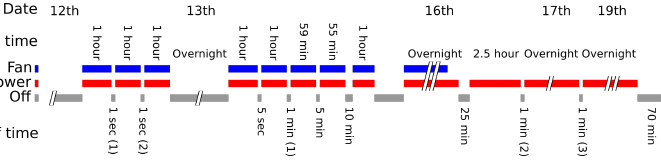
Figure 14. A timeline of the power supply interruption experiment, which took place over multiple days in December 2016. The labels for the periods during which the power supply was interrupted are referenced in the Results section.